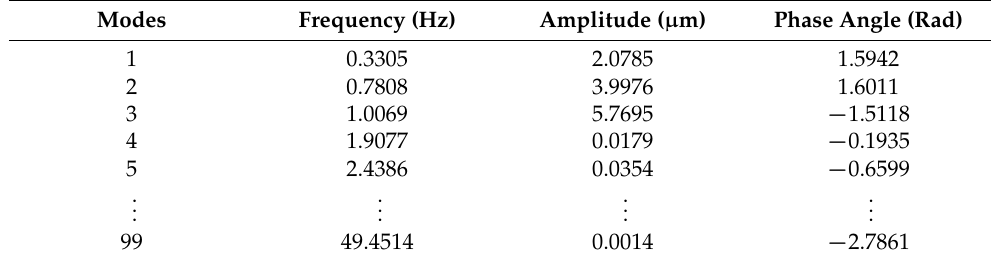
Table 3. Modal parameters of signal A identified with Prony approach.